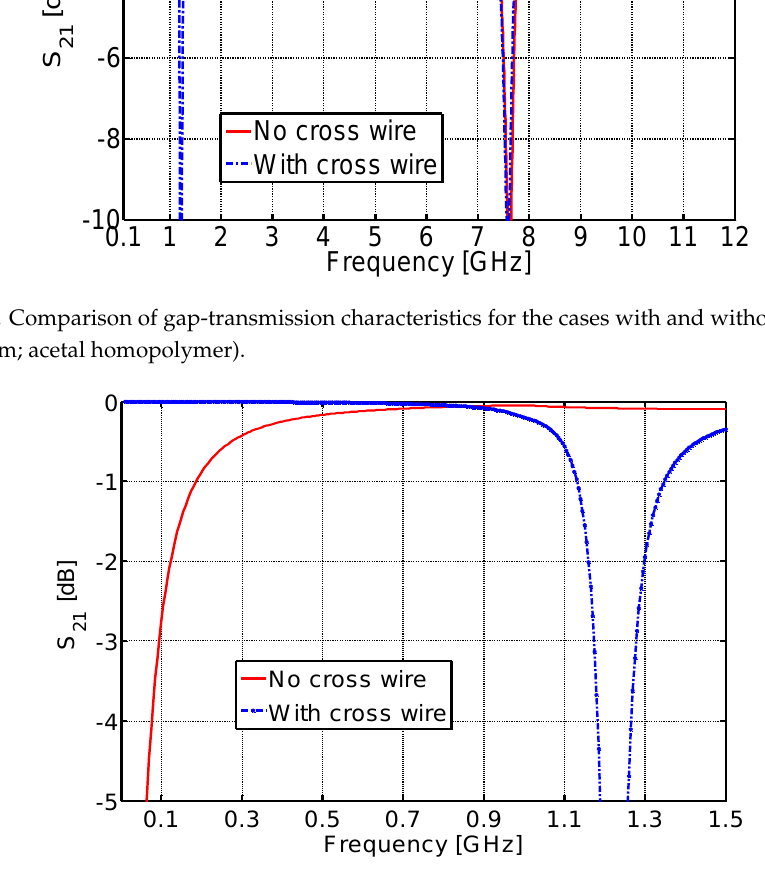
Figure A3. Detailed comparison of gap-transmission characteristics for the cases with and without cross wire in the lower portion of the spectrum ( R ’ = 15 mm; acetal homopolymer).